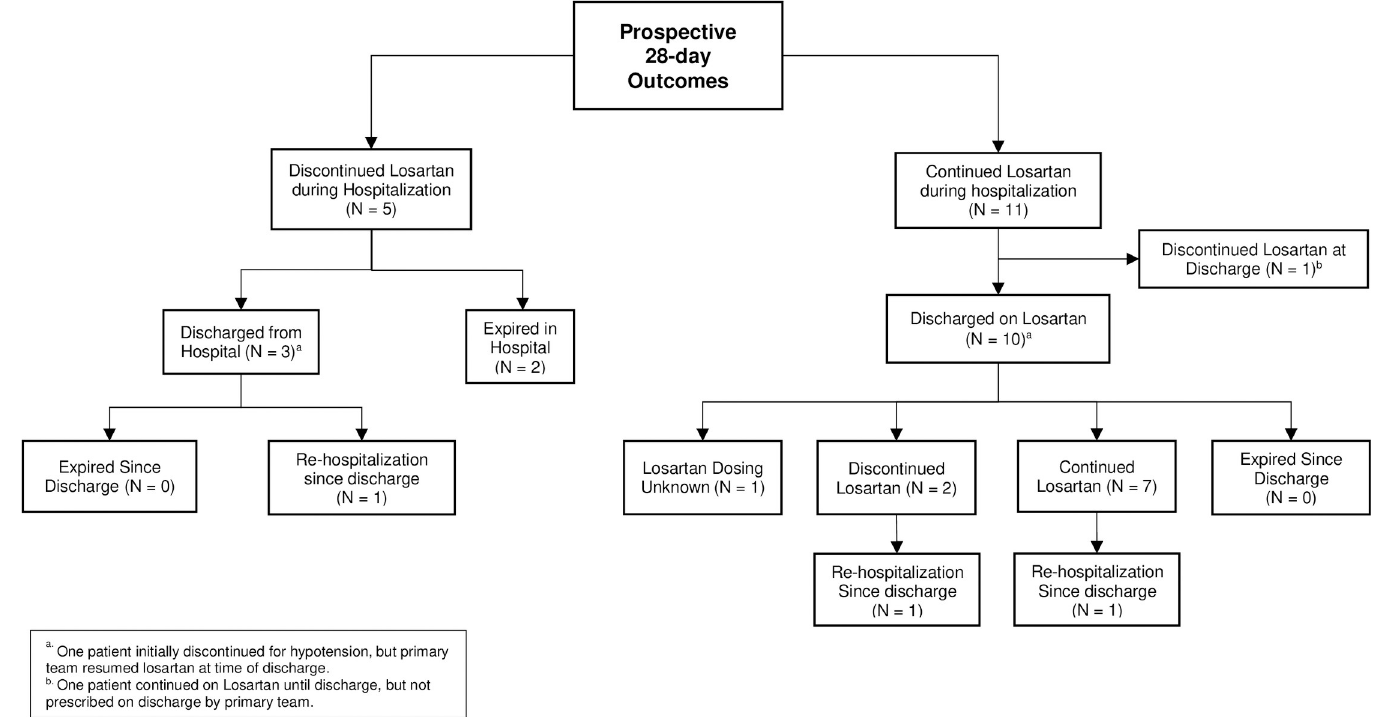
Fig 5. Flow chart for outcomes for patients at 28 days post-discharge in the prospective